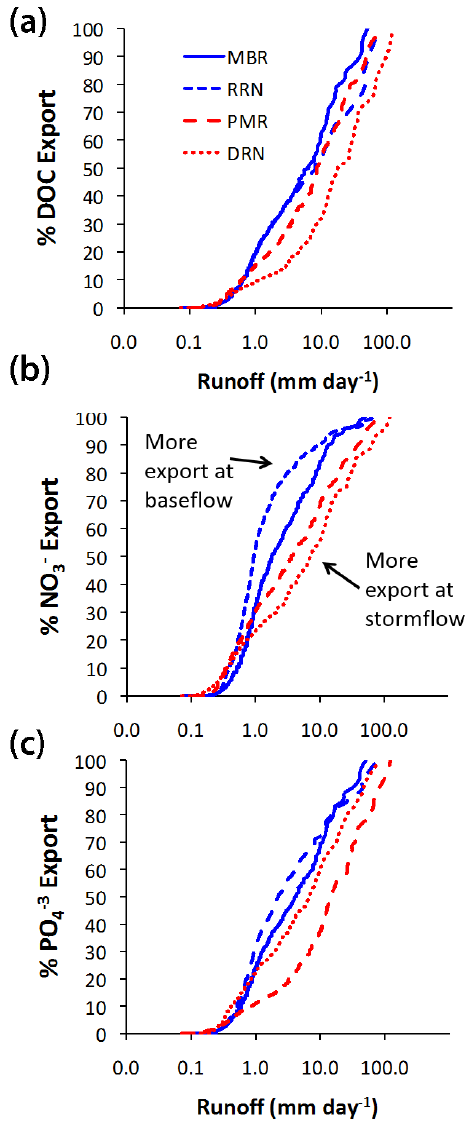
Figure 8. Nutrient duration curves for (a) DOC, (b) NO − (c) PO − 3 daily 4